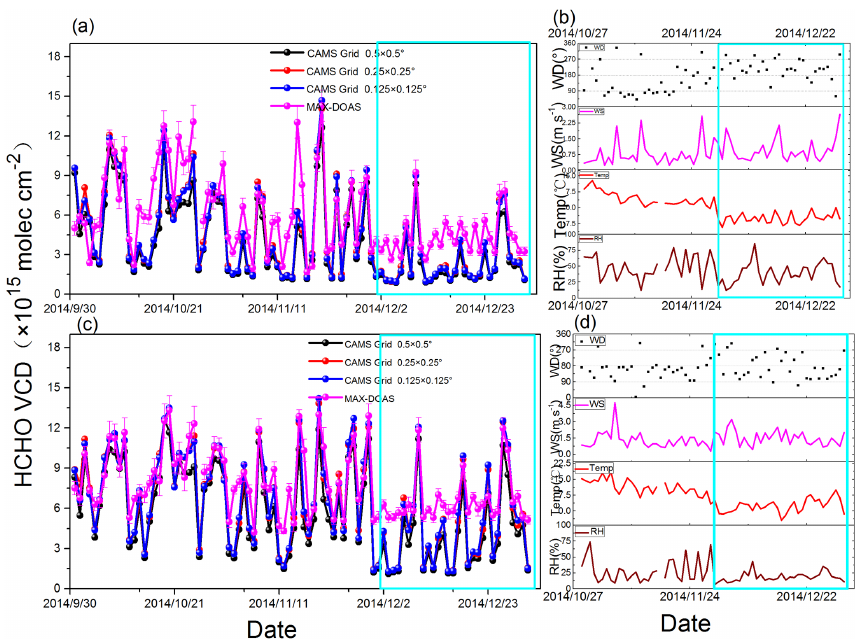
Figure 15. Hourly averaged HCHO VCDs derived from the coincident CAMS model (grid of 0.125 ◦ × 0.125 ◦ , 0.25 ◦ × 0.25 ◦ , and 0.5 ◦ × 0.5 ◦ ) and MAX-DOAS observations at 08:00 (a) and 14:00LT (c) from 1 October to 31 December 2014. Error bars denote re- trieval error. Time series of coincident hourly averaged meteorological parameters measured at the supersite at 08:00 (b) and 14:00LT (d) from 28 October to 31 December 2014.